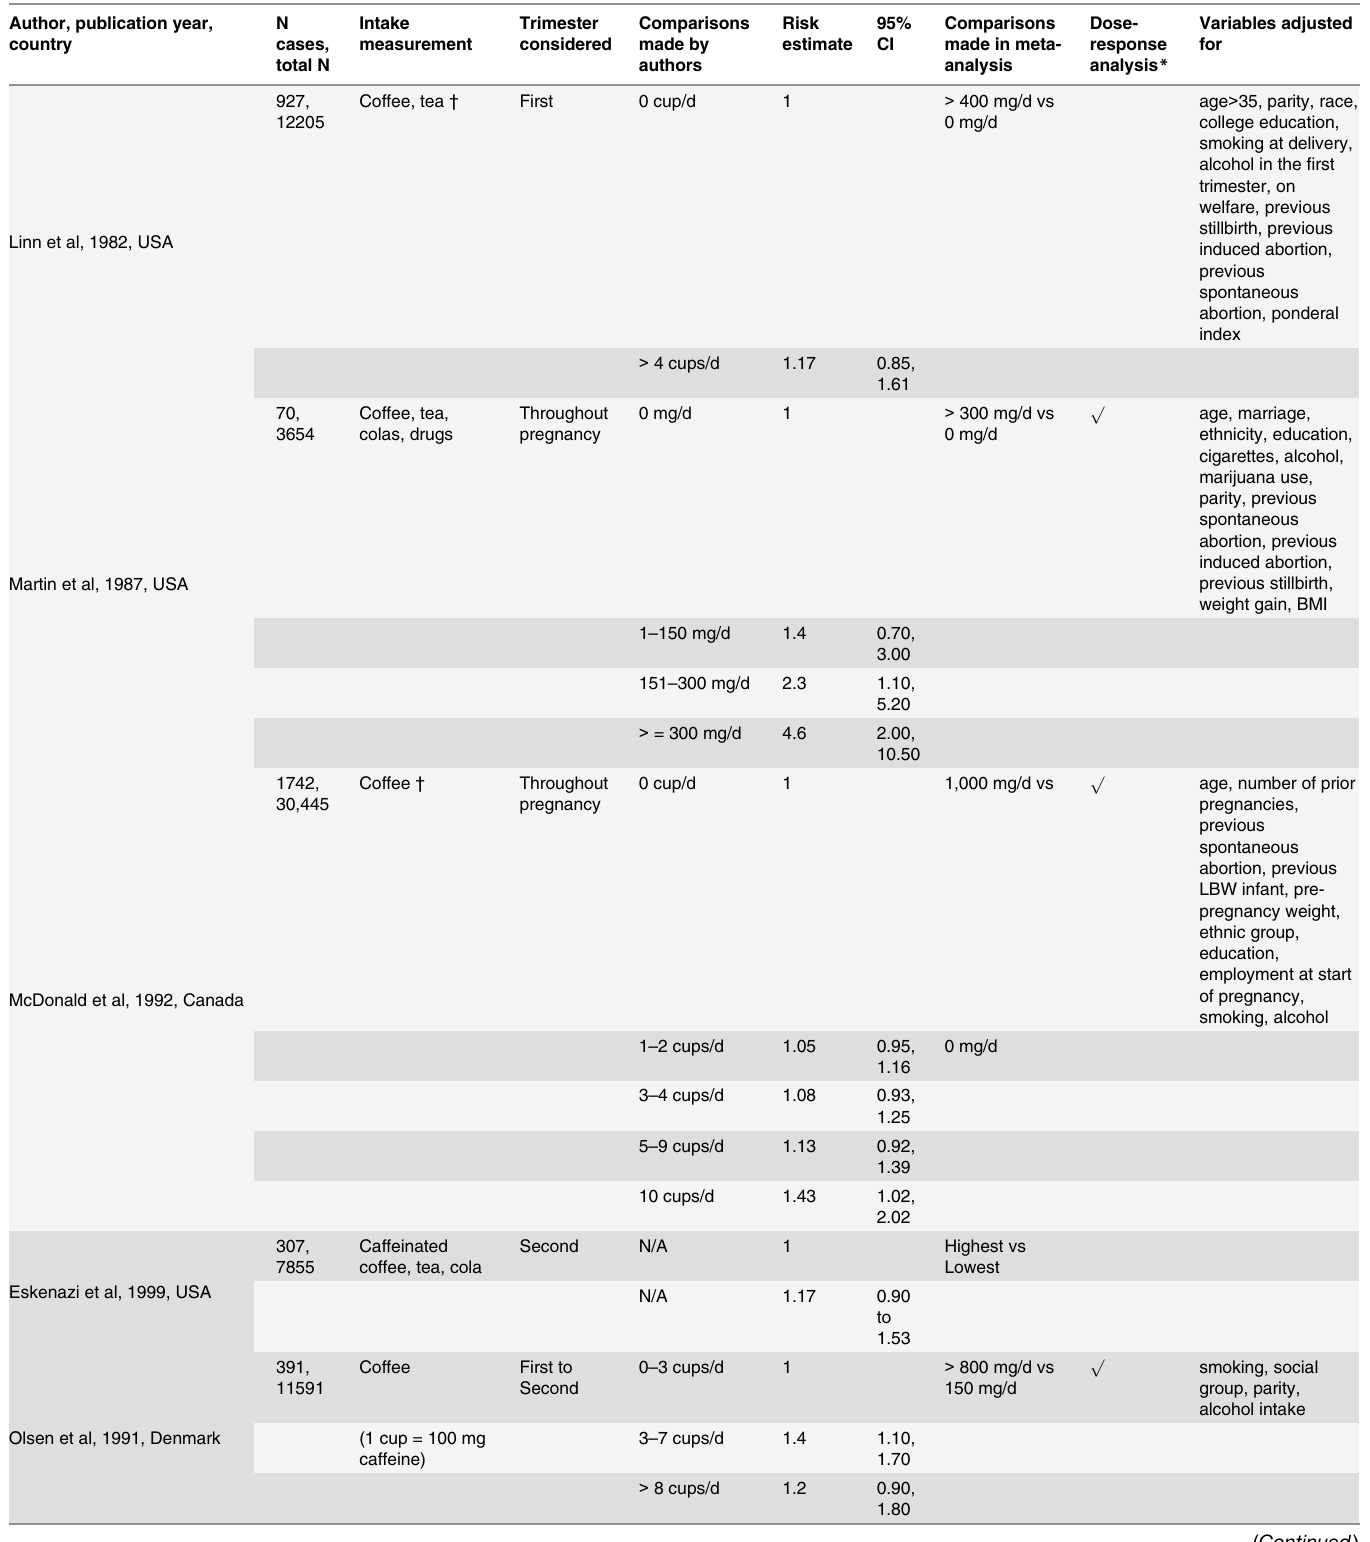
Table 1. Cohort studies of caffeine consumption and risk of low birth